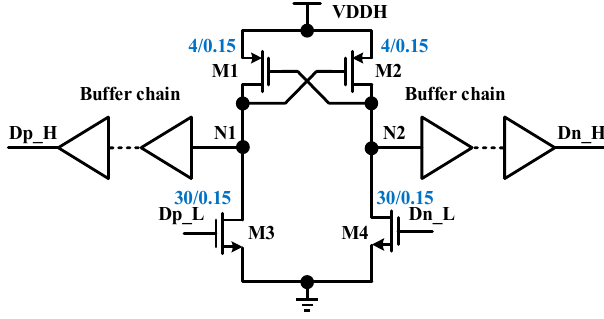
Figure 6. Simplified schematic level shifter.